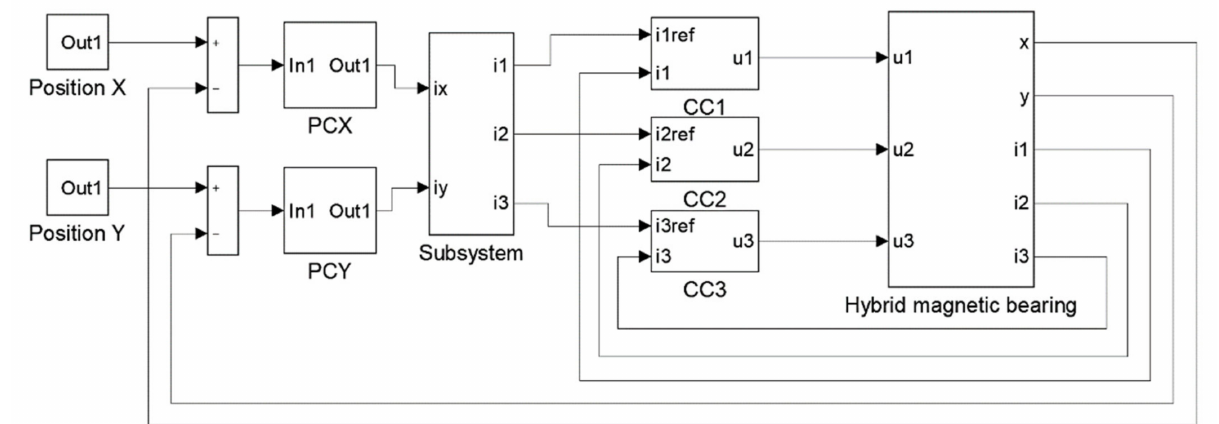
Figure 2. Block diagram of the HMB